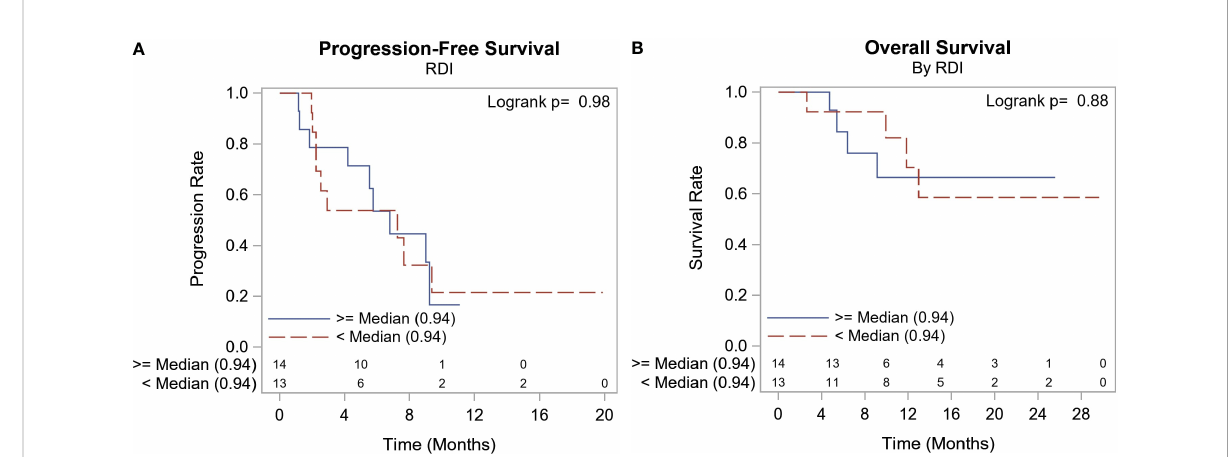
FIGURE 1 Outcome Survival Summary. (A) Median PFS was 6.8 months with 95% CI (2.5, 9.2). (A) 8/27 (29.6%) patients had died, and all deaths were attributed to metastatic breast cancer. The median survival had not been reached, and the 12-month OS/disease-speci fi c survival (DSS) rate was